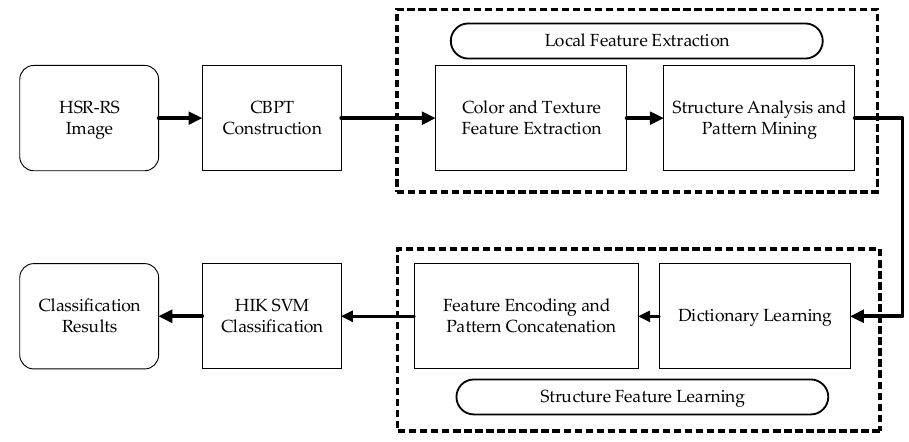
Figure 1. Flowchart of high-resolution satellite (HRS) image classification based on the CTS